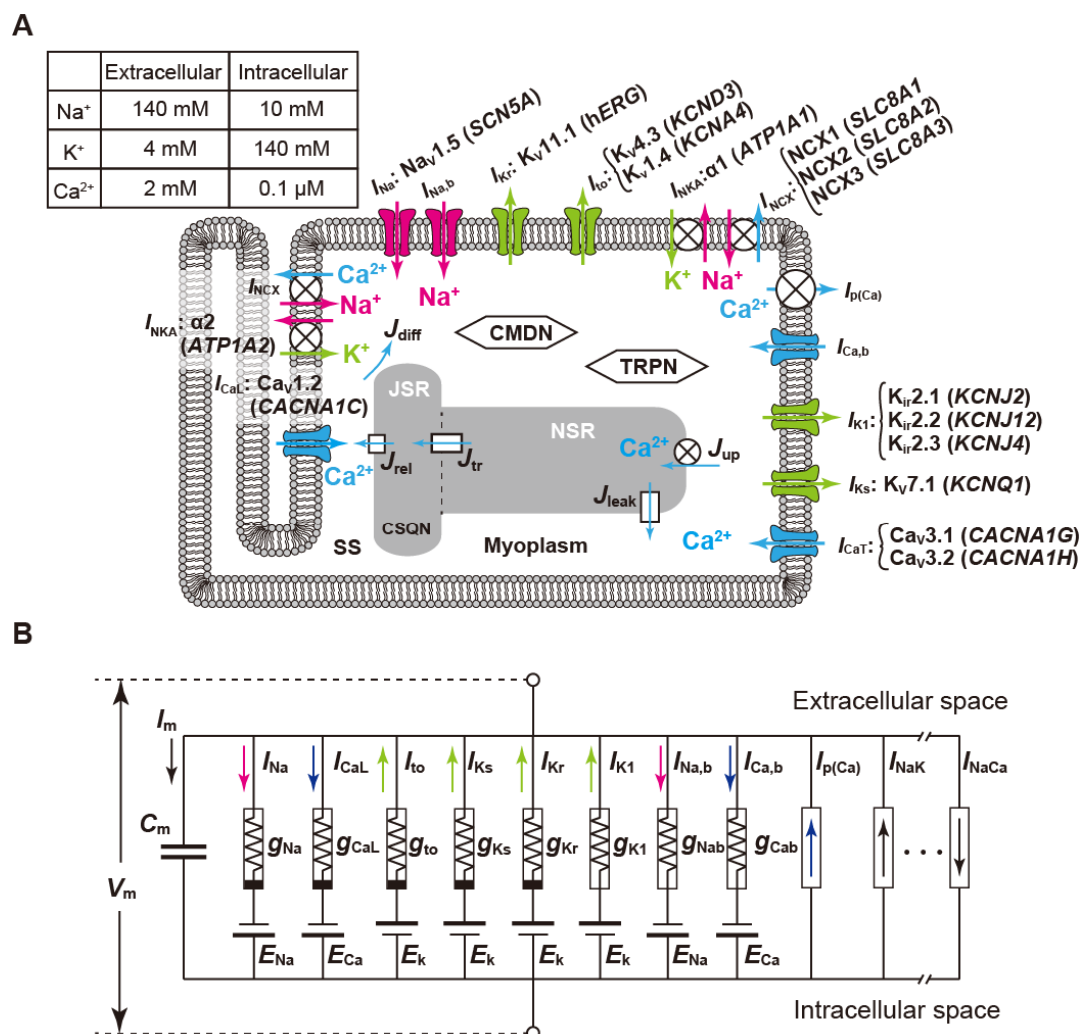
Figure 4. Schematic diagram of the structure and electrical properties of a ventricular myocyte. ( A ): Ion channel and transporter molecules embedded in the cell membrane, sarcoplasmic reticulum (Ca 2+ cycling), and Ca 2+ -binding molecules related to excitation and contraction. ( B ): An equivalent circuit model of the cell membrane, composed of the ion channel conductance (g), membrane capacitance ( C m ), and electromotive force ( E ) representing ion concentration gradients. The current ( I ) flowing through each voltage-gated ion channel is represented by the product of the time-dependent variable conductance and driving force as the difference between the membrane potential ( V m ) and individual reversal potential. g x : maximum conductance of ion channels x , for x = Na + , Ca 2+ , K + , etc.; I Na : fast sodium channel current; I to : transient outward K + channel current; I Kr and I Ks : fast and slow components, respectively, of delayed rectifier K + channel currents; I CaL : L-type Ca 2+ channel current; I CaT : T-type Ca 2+ channel current; I K1 : inward rectifier K + channel current; I NKA : Na + /K + ATPase current; I NCX : Na + /Ca 2+ exchanger current; I p(Ca) : Ca 2+ pump current in the sarcolemmal membrane; J rel : SR Ca 2+ release flux by Ca 2+ -induced Ca 2+ -release; J up : Ca 2+ uptake flux via Ca 2+ pump (SERCA) in the SR; J leak : Ca 2+ leakage flux from the SR; JSR: junctional SR; NSR: network SR; CMDN: calmodulin; TRPN: troponin; SS: a subspace of the myoplasm. For details of other symbols, refer to references [99,114–117].